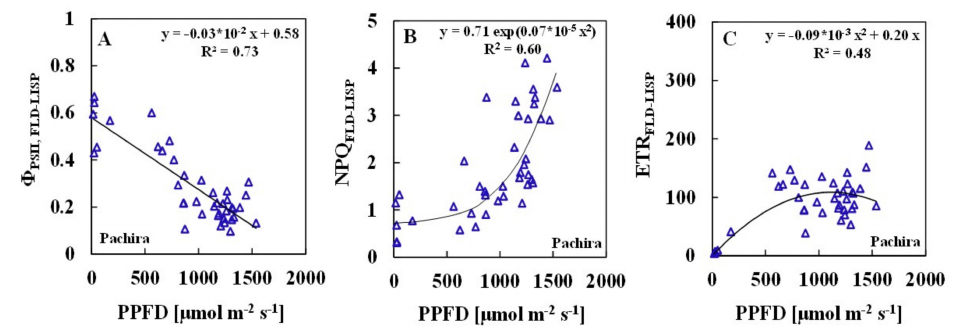
Figure 6. Relationships between the solar PPFD and ChlF parameters ( A ) Φ PSII ; ( B ) NPQ; and ( C ) ETR of pachira leaves estimated by the FLD-LISP method. The results of the PAM method were very similar and the details are given in Table 1.